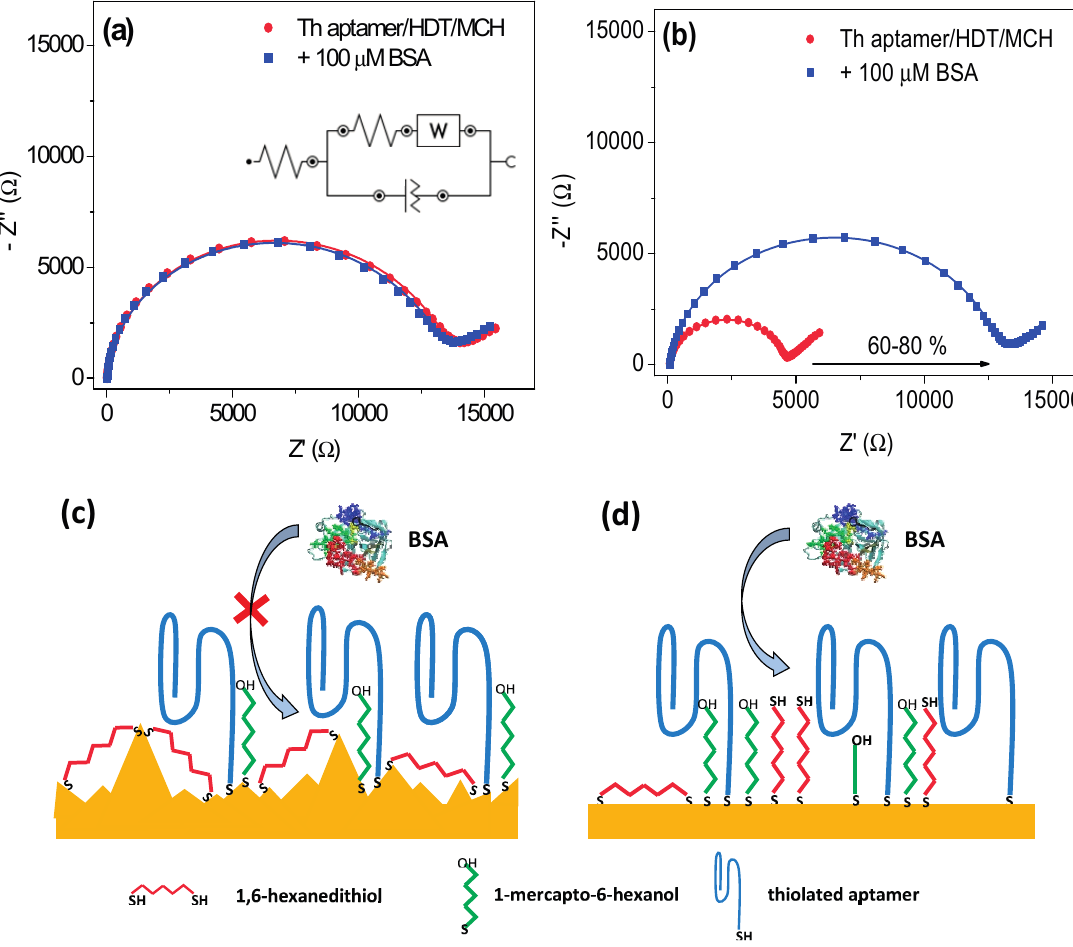
Figure 1. Nyquist plots showing electrochemical impedance spectroscopy responses before (red) and after (blue) incubation of 100 μ M bovine serum albumin (BSA) for 30 min on biosensor based on ( a ) screen-printed electrodes ( b ) macroelectrodes modified with thrombin aptamer/ternary self-assembled monolayer 0.05/300 μ M and saturated with 1 mM mercaptohexanol. Points show experimental results and solid plots show fitting. Scheme of the surface architecture for ( c ) screen-printed electrodes and ( d )